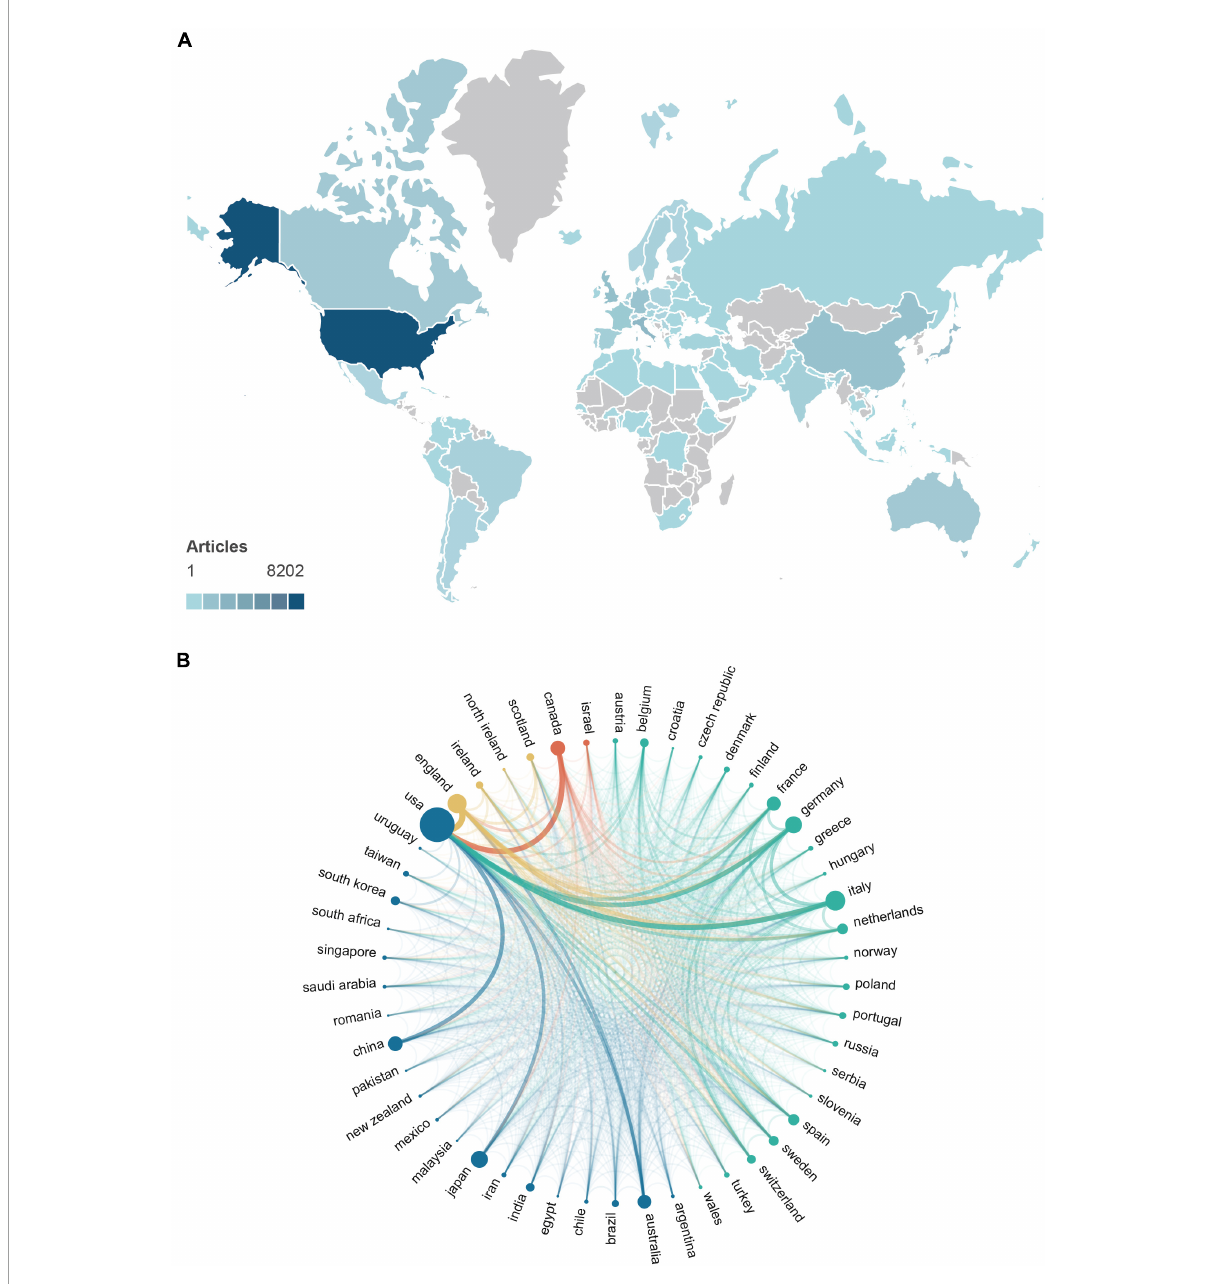
FIGURE1 (A) Distribution of countries contributing to ALS investigation (the depth of the color represents the number of documents from the country or region; gray represents countries with no publications). (B) Collaboration network of the top 50 countries with the highest number of publications (the countries that frequently collaborate are classified in the same color; the circle size indicates the number of publications; and the line thickness indicates the number of co-authored